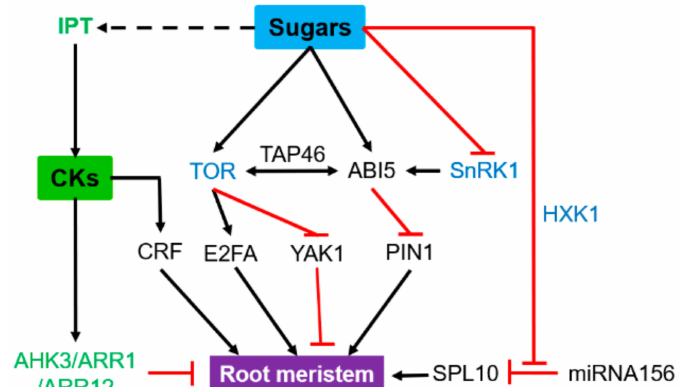
Figure 3. Antagonistic effect of sugars and cytokinins (CKs) on the functioning of the root meristem. Blue indicates sugar signaling pathways, and green highlights genes involved in CK synthesis or signaling pathways. Black arrows and red lines indicate stimulatory and inhibitory effects, respectively. Solid line, direct effect; dotted indirect effect. ABI5, abscisic acid insensitive 5; AHK3, Arabidopsis histidine kinase 3; ARR, Arabidopsis response regulator; CRF, cytokinin response factor; HXK1, hexokinase 1; E2FA, elongation 2 factor A; IPT, isopentenyl transferase; PIN1, PIN-FORMED 1; SnRK1, SNF1-related kinase1; SPL10, Squamosa Promoter Binding Protein-Like 10; TAP46,